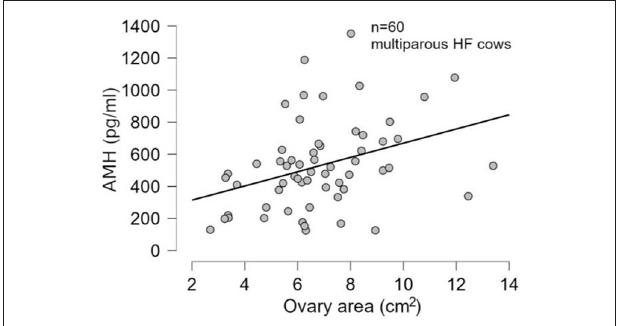
FIGURE 2 | Data indicating a significant correlation ( p -value = 0.00475) between large ovary size (large area) and blood AMH levels. HF, Holstein–Friesian; AMH, anti-Müllerian hormone.